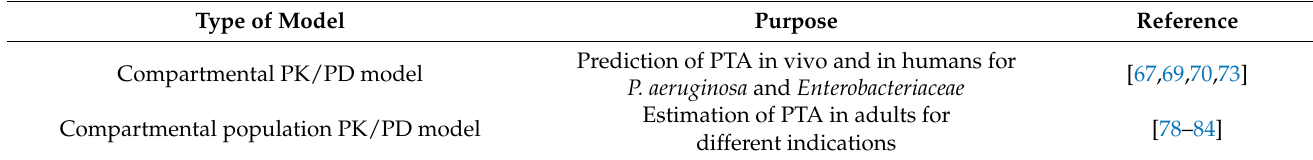
Table 1. PK/PD models used for